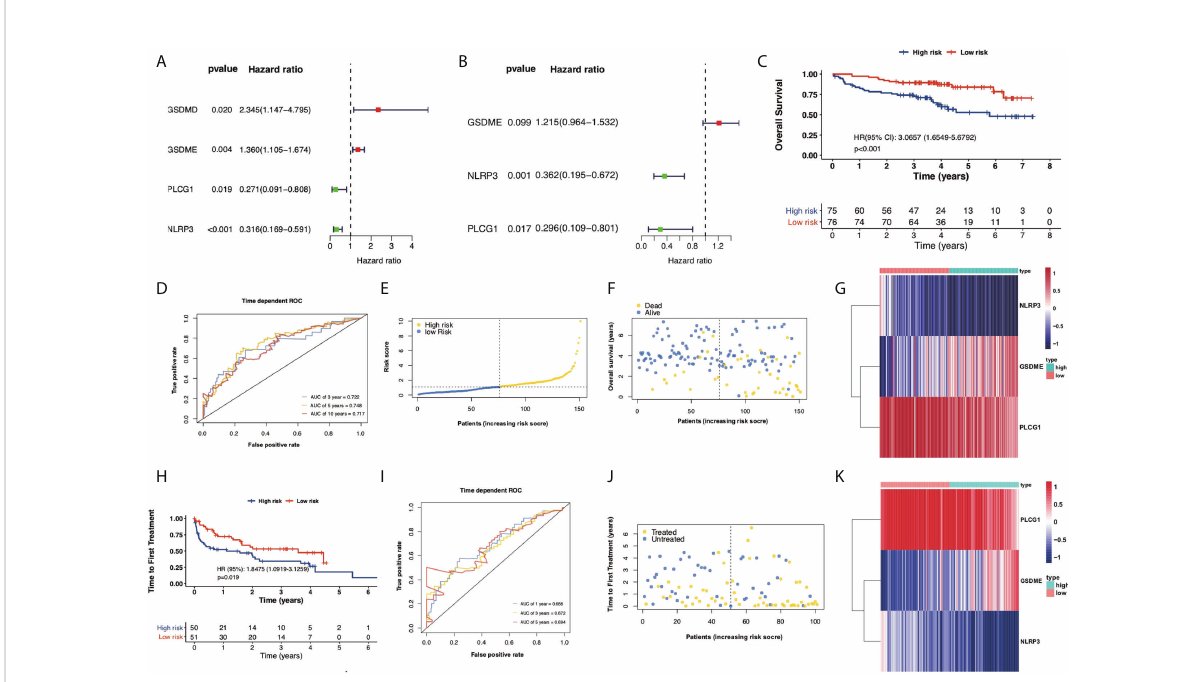
FIGURE 3 Construction of prognostic model according to multivariable Cox regression analysis. (A) Univariate Cox regression analysis of OS for each pyroptosis-related gene and six genes with p < 0.05. (B) Multivariate Cox regression analysis of OS for screened pyroptosis-related genes. (C) Kaplan – Meier plot showed OS of CLL samples in the high- and low-risk subgroups. (D) ROC curves showed the predictive ef fi ciency of risk model in terms of 3-year, 5-year, and 10-year OS. (E) Distribution of patients based on the risk score. (F) Survival status of CLL samples (low risk on the left side of the dotted line and high risk on the right side of the dotted line). (G) Heatmap for expression of screened pyroptosis-related genes between high-risk and low-risk subgroups. (H) Kaplan – Meier plot showed TTFT of 101 CLL samples between high- and low-risk subgroups. (I) ROC curves showed the predictive ef fi ciency of the risk model in 101 CLL samples in terms of 1-year, 3-year, and 5-year TTFT. (J) Treatment status of 101 CLL samples. (K) Heatmap for expression of screened pyroptosis-related genes between high-risk and low-risk subgroups in 101 CLL